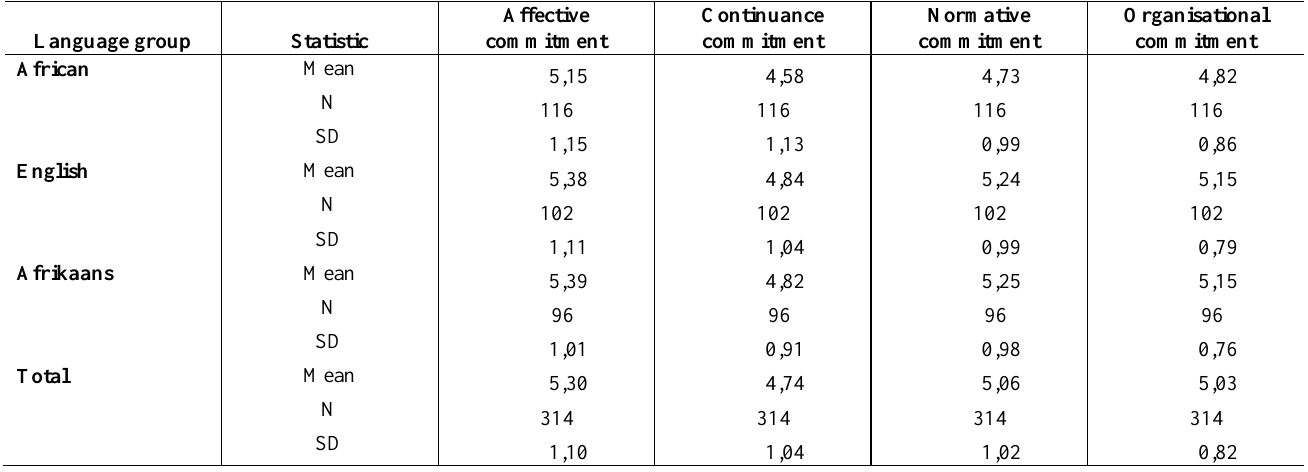
Table 1: Means and standard deviations for the three subscales and overall organisation commitment scale across language groups Language